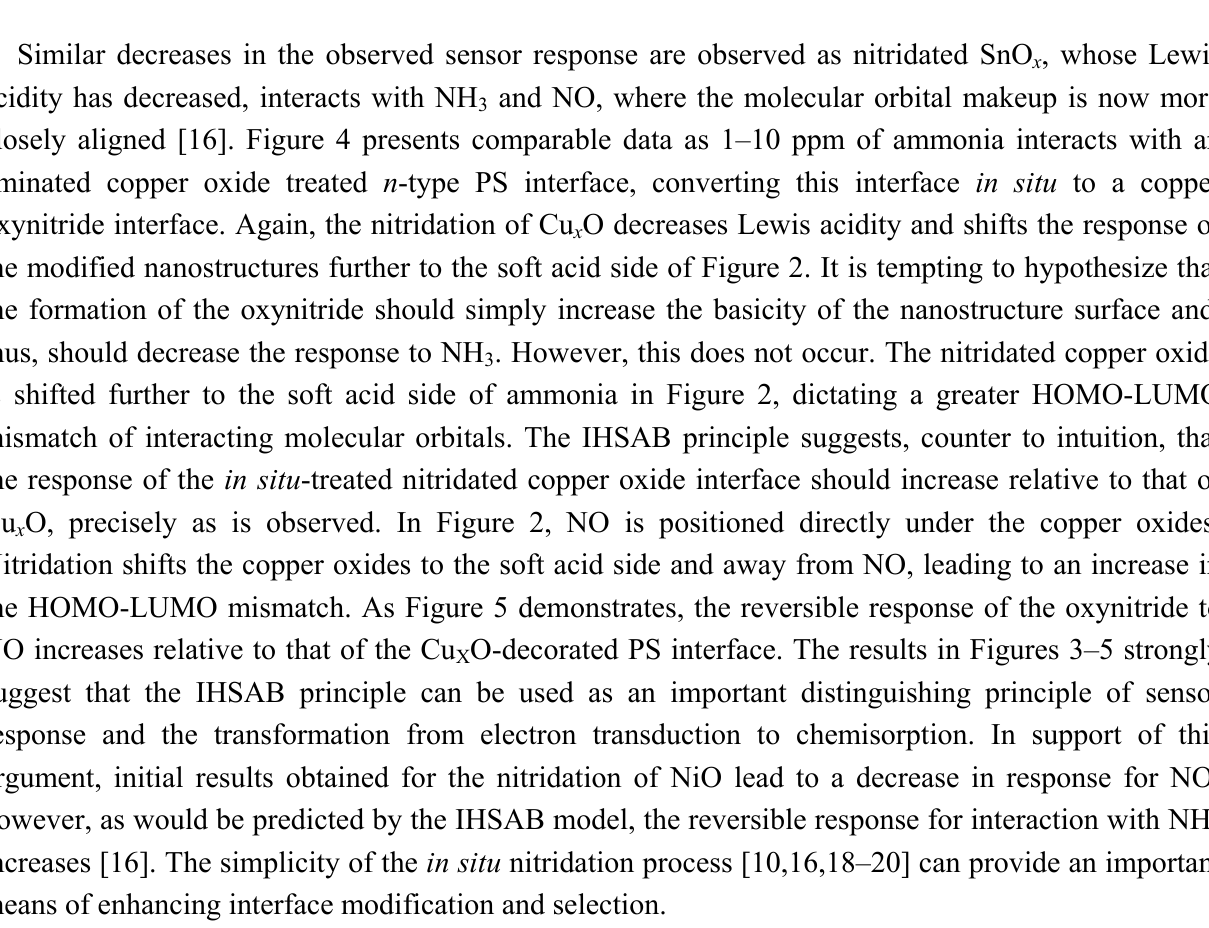
contributes electrons to 3 - and TiO N -treated PS interfaces. The 2 2 − x x - treated PS acidic 2